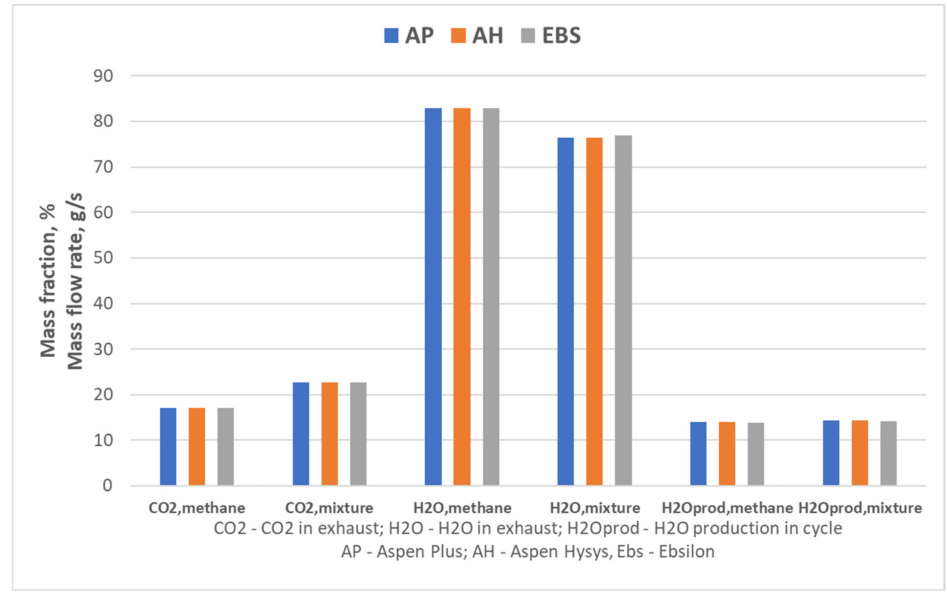
Figure 10. Exhaust CO 2 , H 2 O fraction and mass flow of water production in the cycle for various